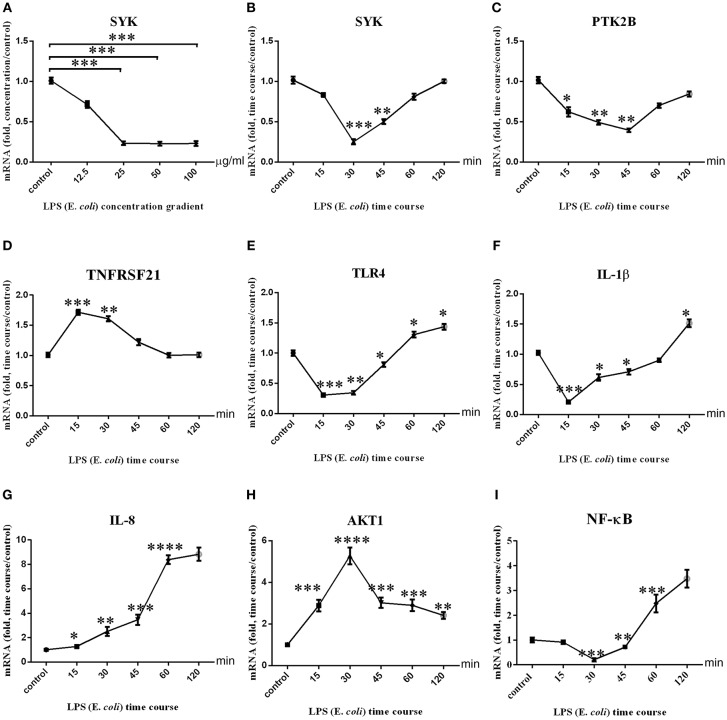
Three immune-related candidate genes, TLR4, AKT1, NF-κB, IL-1β, IL-8, and mRNA expression levels in bMECs. (A) The mRNA expression level of SYK after stimulation of BMSCs by LPS concentration gradient. (B–I) The mRNA expression levels of SYK, PTK2B, TNFRSF21, TLR4, AKT1, IL-1β, and IL-8 after stimulation of bMECs by LPS (E. coli, 25 μg/ml) time courses. ****represent P < 0.0001. ***represent P < 0.001. **represent P < 0.01. *represent P < 0.05.